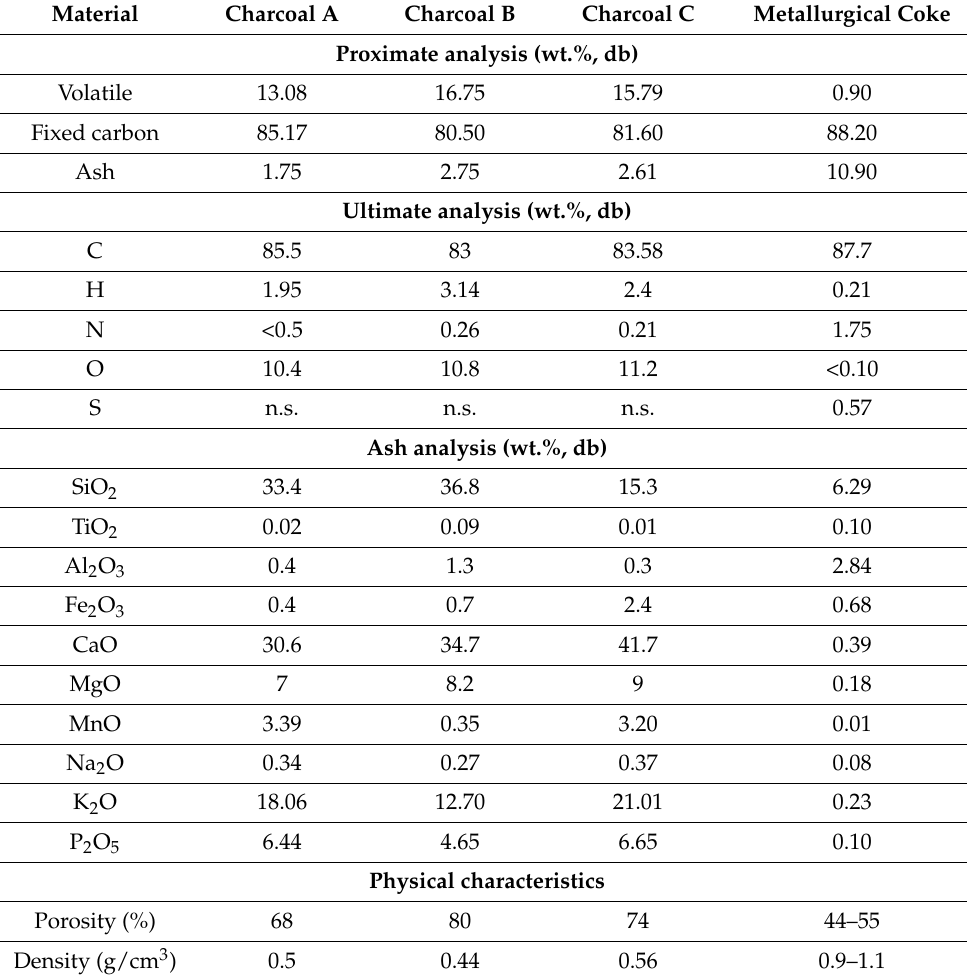
Table 2. Proximate and ultimate analysis of the feedstock